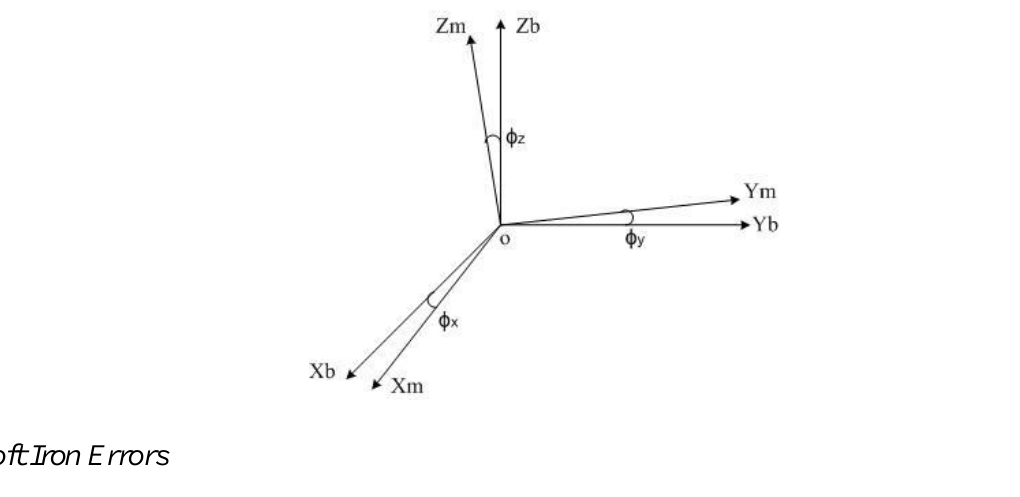
Figure 2. Body orthogonal coordinate system and virtual orthogonal coordinate